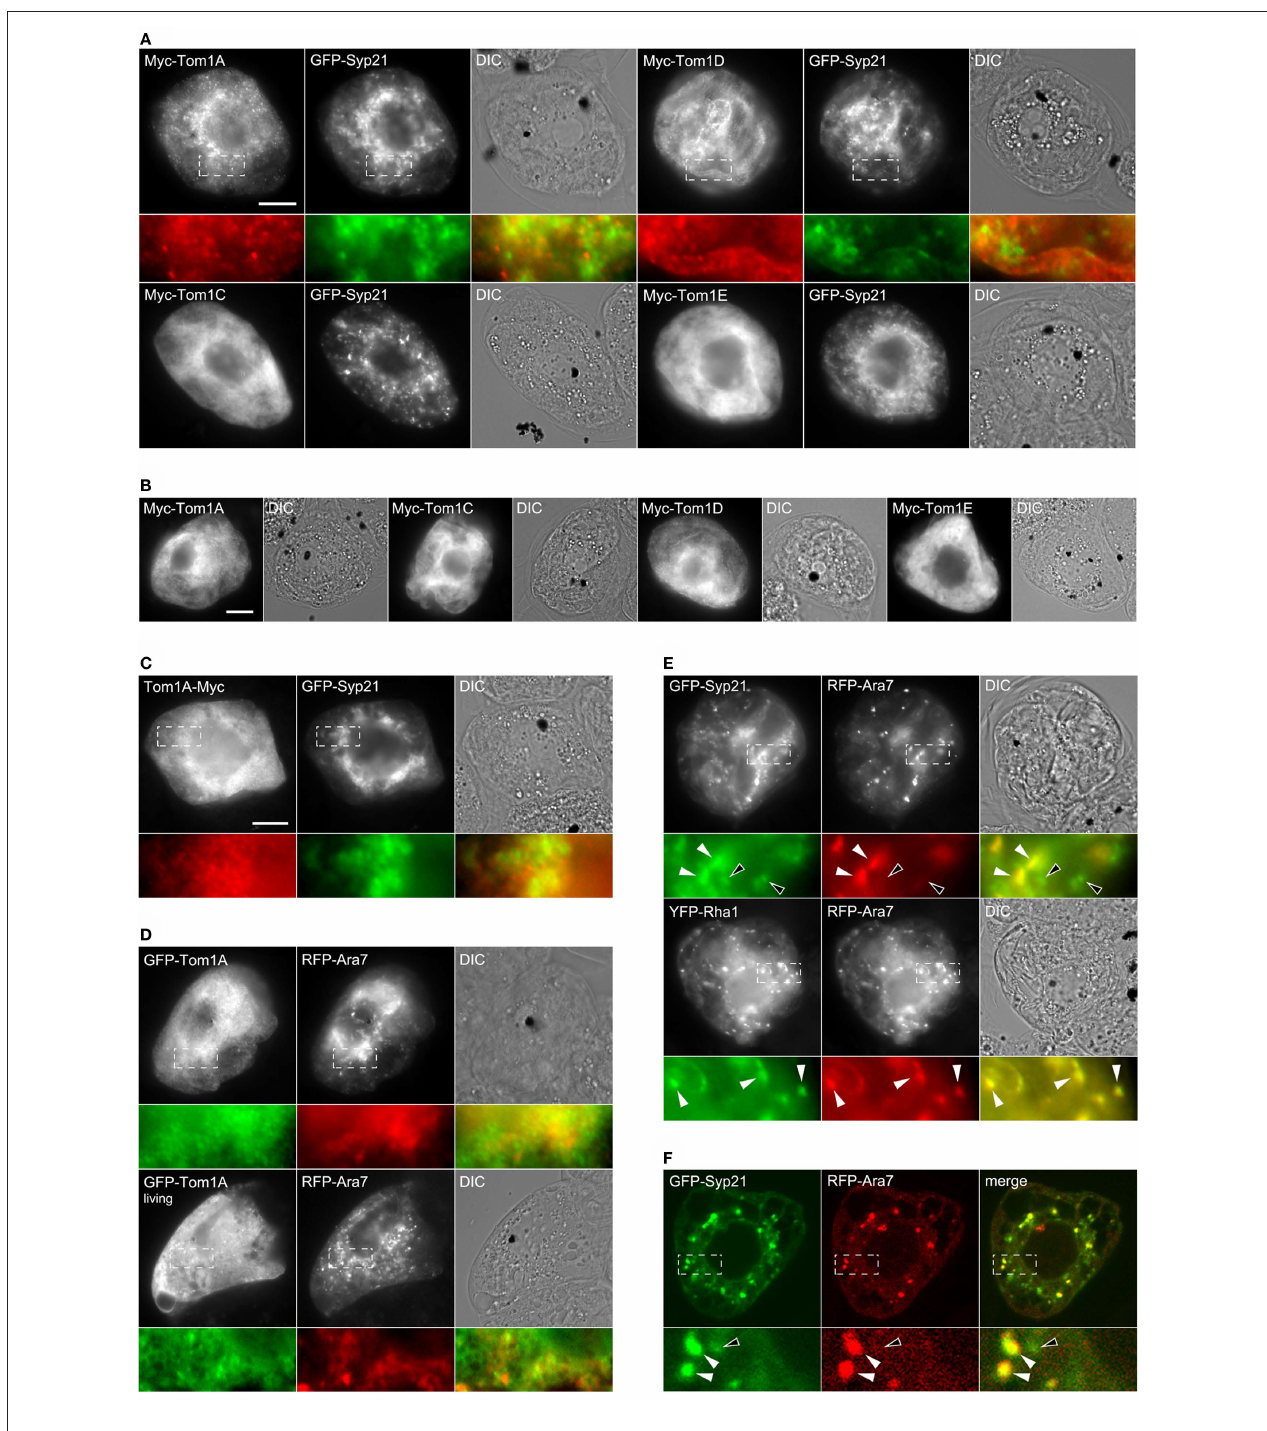
FIGuRE 2 | Subcellular localization of Arabidopsis Tom1 proteins, GFP-Syp21, YFP-Rha1, and RFP-Ara7. BY‑2 cells were either transiently (co‑)transformed with either (A) various Myc‑tagged Tom1 proteins and GFP‑Syp21, (B) the same Myc‑Tom1 proteins on their own, (C) Tom1A‑Myc and GFP‑Syp21, (D) GFP‑Tom1A and RFP‑Ara7, (E) GFP‑Syp21 and RFP‑Ara7 or YFP‑Rha1 and RFP‑Ara7, or (F) GFP‑Syp21 and RFP‑Ara7. Cells were then either formaldehyde‑fixed and processed for immuno‑epifluorescence microscopy or [in (F) ] CLSM. Alternatively, cells [in (D) bottom row) were viewed living (i.e., non‑fixed) using epifluorescence